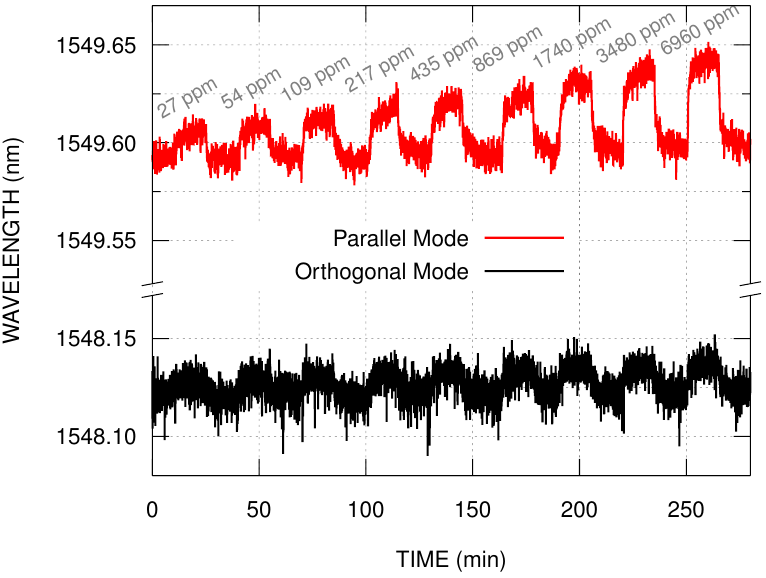
Figure 4. Wavelength shifts of the parallel and the orthogonal modes in the presence of ammonia vapor with concentration ranging from 27ppm to